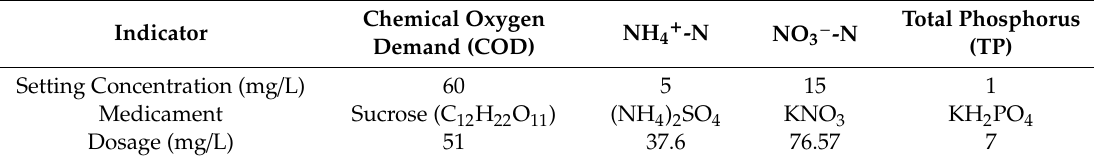
Table 1. Influent water quality